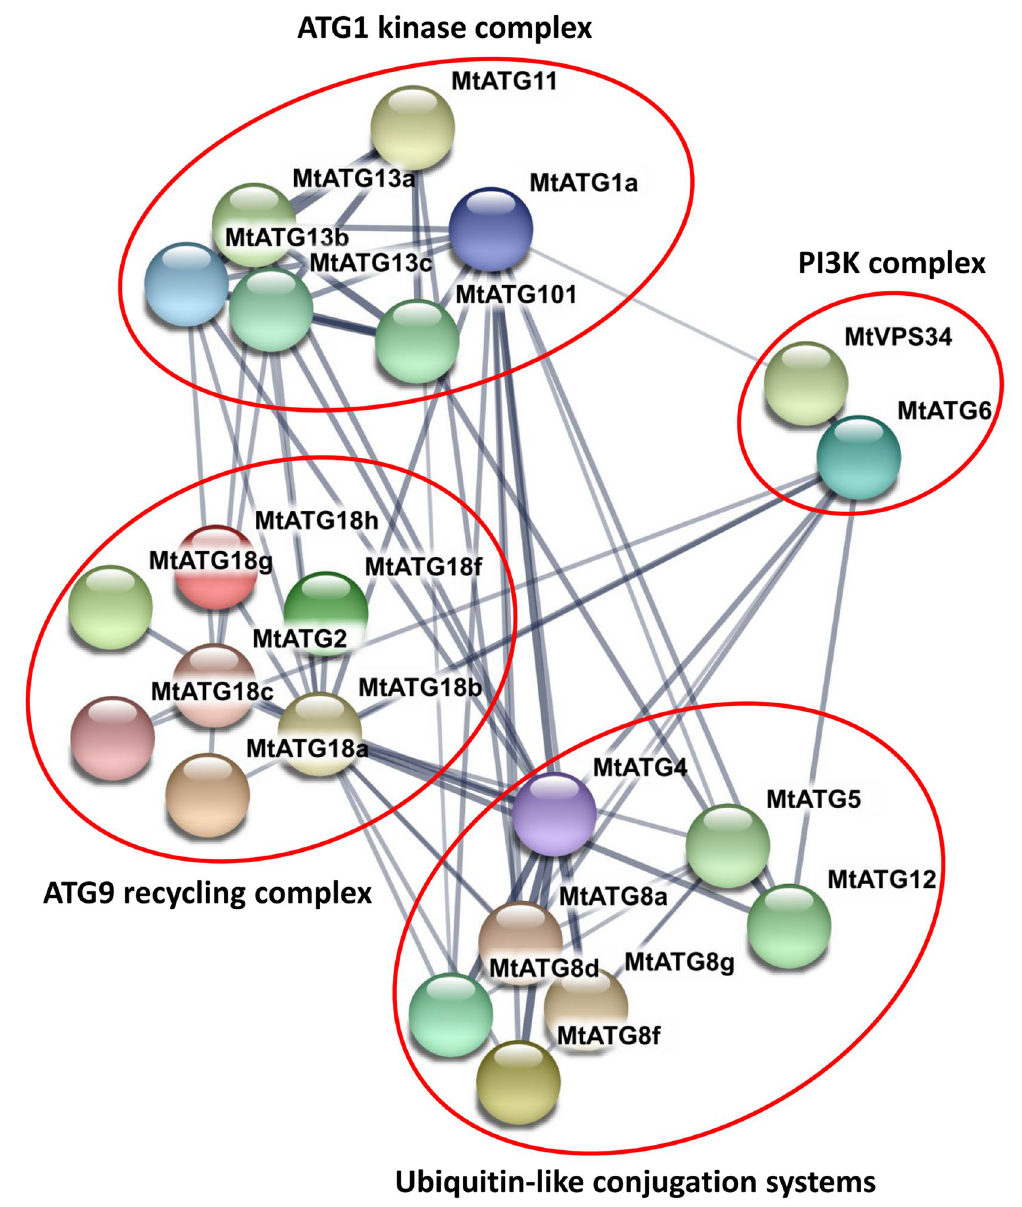
Figure 5. Protein–protein interaction network of Mt ATGs. The associations among proteins are derived from various channels: textmining, experiments, databases, coexpression, neighborhood, gene fusion, and co-occurrence. The thickness of the lines indicates the strength of data